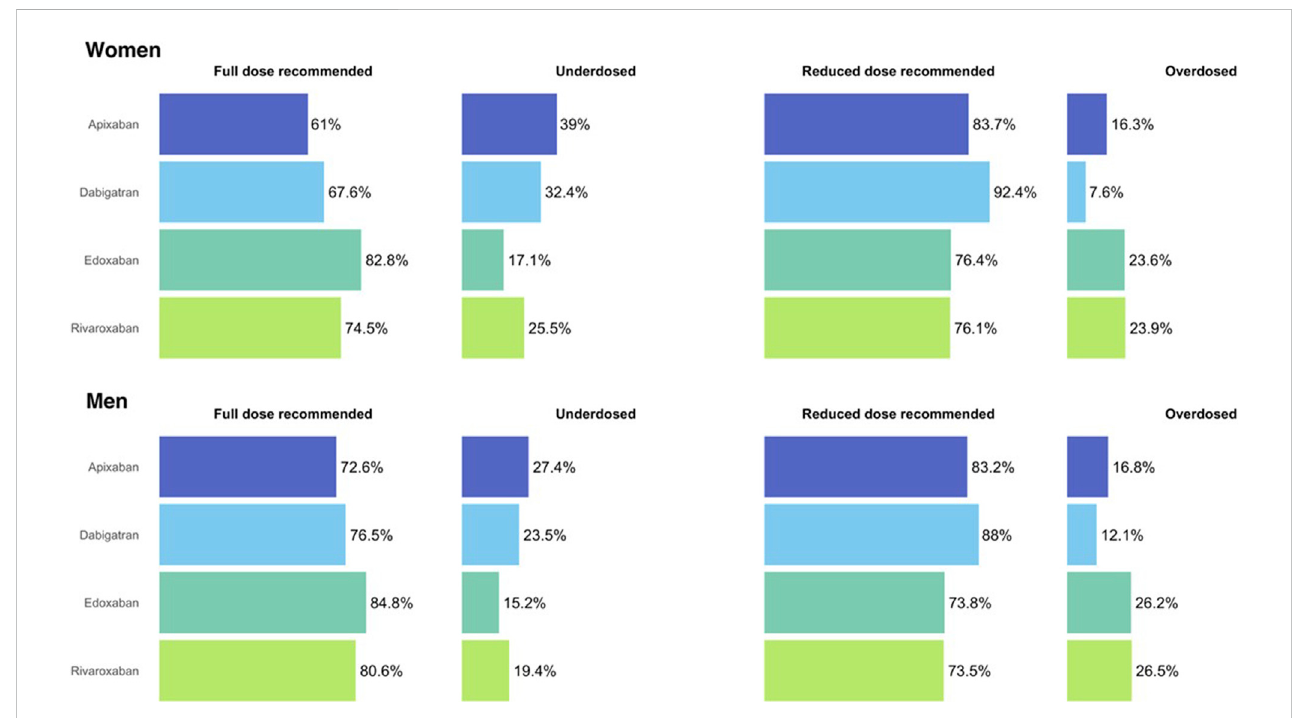
FIGURE 3 Dose adequacy in women and men initiating treatment with direct oral anticoagulants. Figure 3 shows the dose adequacy for all direct oral anticoagulants, women at the upper part and men at the bottom.